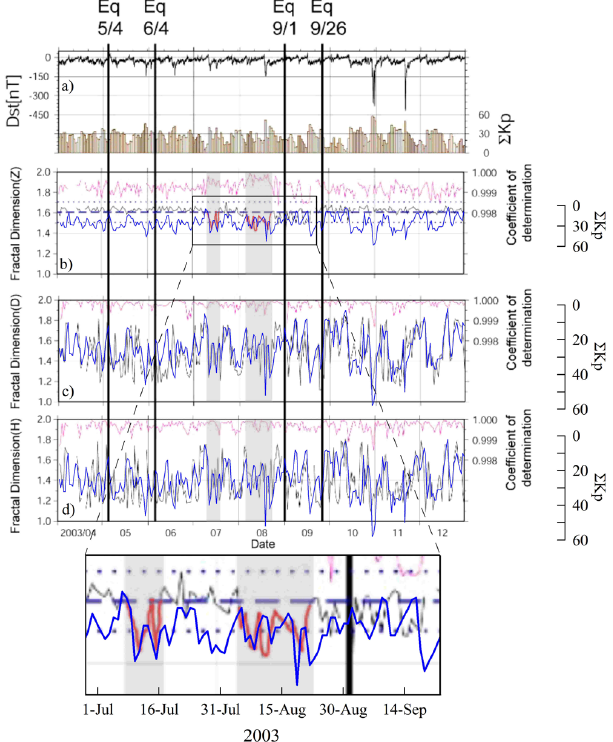
Fig. 1. A reproduction of Fig. 3 by Ida et al. (2012). Note that in the original figure panels (a) and (c) are horizontally shifted by about 1 day with respect to panels (b) and (d) . (a) denotes geomagnetic indices Dst and 6 Kp time series. (b) , (c) , and (d) indicate fractal dimension daily values of the geomagnetic field components Z , D , and H , respectively. Vertical black lines refer to the M w > 5 earth- quakes of 2003. Red lines highlight the pre-earthquake decreases of the fractal dimension of the Z component claimed to have a seis- mogenic origin by Ida et al. (2012). 6 Kp index time series has been superimposed onto panels (b) , (c) , and (d) . An enlarged view of the presumed seismogenic fractal anomalies is shown on the bottom of the figure. See text for